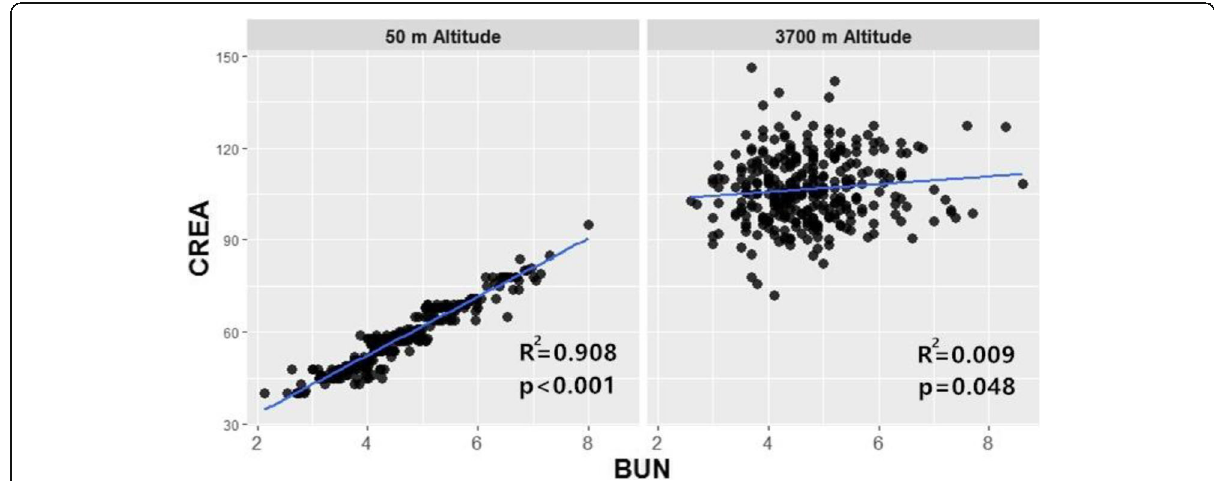
Fig. 2 the correlation between BUN and creatinine at 50 m and 3700 m. BUN, Blood urea nitrogen (mmol/L); CREA, creatinine